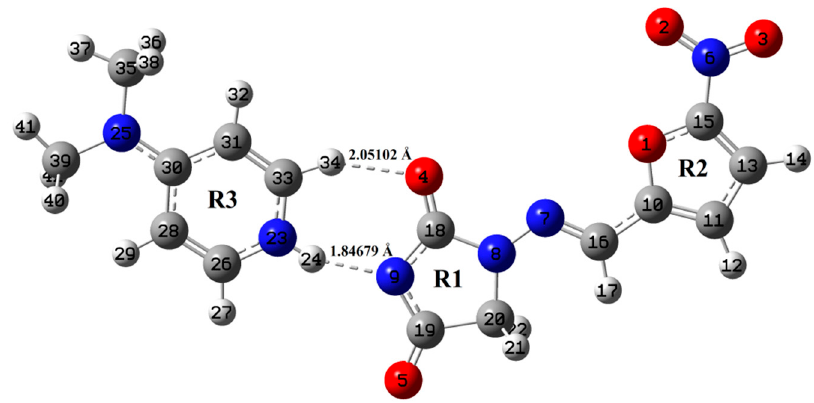
Figure 2. Optimized structure of NF-DMAP using wB97X-D method.